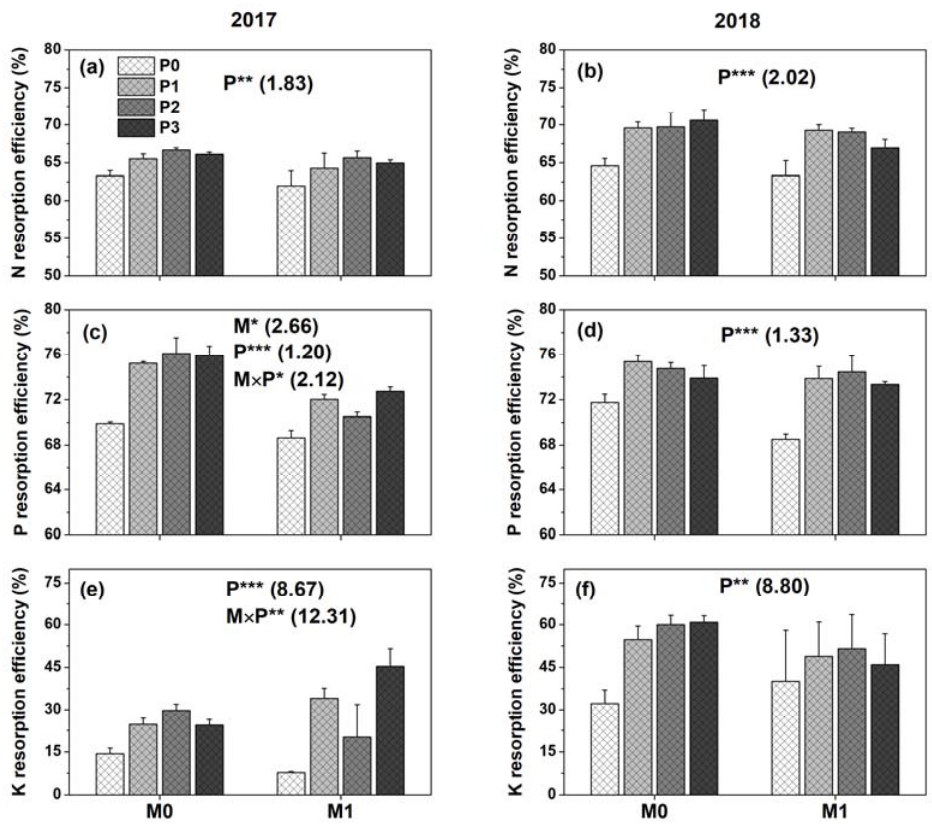
Figure 4. Effect of film mulch (M) and P fertilization (P) on resorption efficiencies for ( a, b ) N, ( c, d ) P, and ( e , f ) K in 2017 and 2018. M0P0, M0P1, M0P2, M0P3, M1P0, M1P1, M1P2, and M1P3 represent no mulch (M0) and mulch (M1) with four levels of P (P0, P1, P2, and P3), respectively. ***, p ≤ 0.001; **, p ≤ 0.01; *, p ≤ 0.05. Numbers in parentheses are LSD values among treatments ( p = 0.05). Error bars show one standard error of the mean.